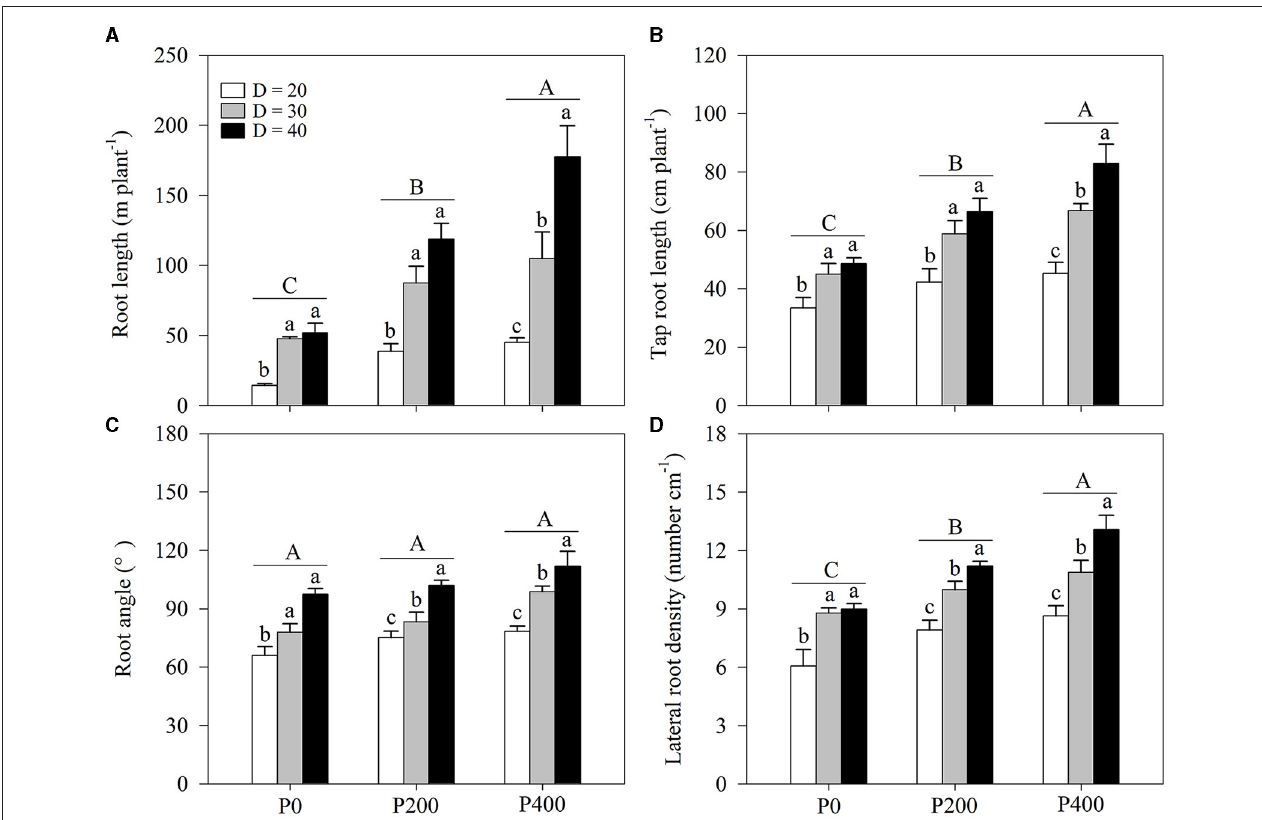
FIGURE 3 | (A) Root length, (B) tap root length, (C) root angle, and (D) lateral root density under different phosphorous (P) supply gradients and space availability conditions. Each value represents the mean of four replicates ( + SD). Different lower-case letters indicate a significant difference among different space availability levels, and different capital letters indicate a significant among different P levels ( P < 0.05). P0, 0mg P kg − 1 soil; P200, 200mg P kg − 1 soil; and P400, 400mg P kg − 1 soil; D = 20, D = 30, and D = 40 represent diameter of pot is 20, 30, and 40cm,